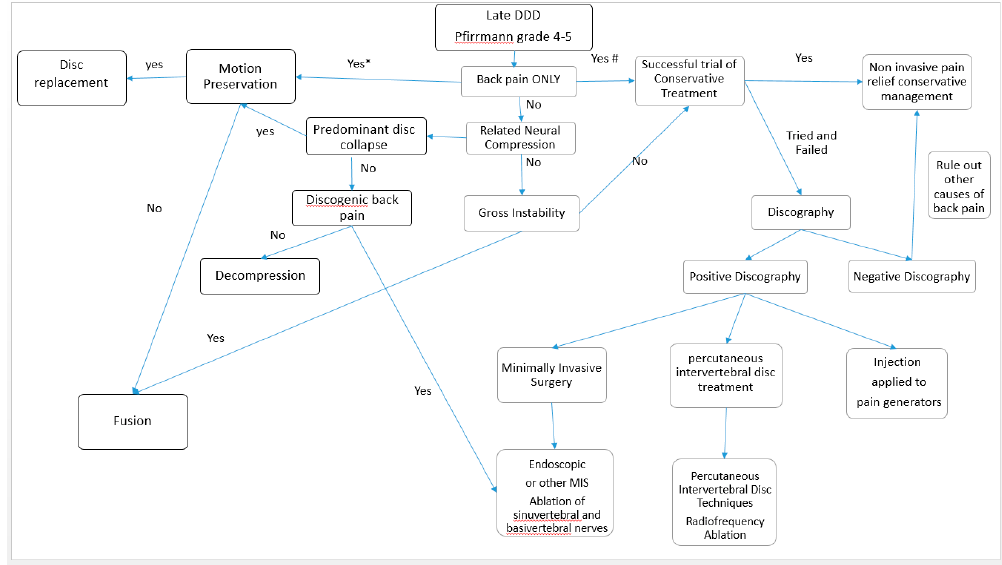
Figure 4. Decision flow chart in clinical practice for patients with late degenerative disc disease, Pfirrmann grade 4–5. We assess for any related pure axial back pain, neural compression, and instability. If there is no neural compression or instability and only pure axial back pain, the patient should be o ff ered a trial of conservative noninvasive treatment as a first line of treatment (#). It is controversial regarding total disc replacement and fusion surgery as a first line of definitive treatment for back pain. Both are invasive and irreversible procedures; hence, they should be considered as a last option in